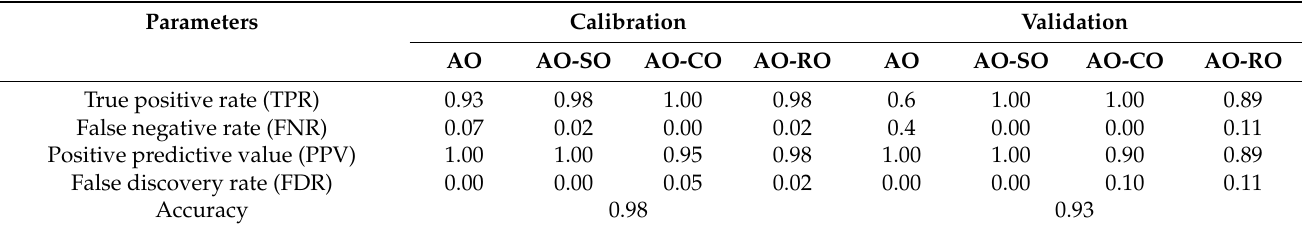
Table 2. Evaluation of the prediction performance of SIMCA models based on the parameters TPR, FNR, PPV, FDR and